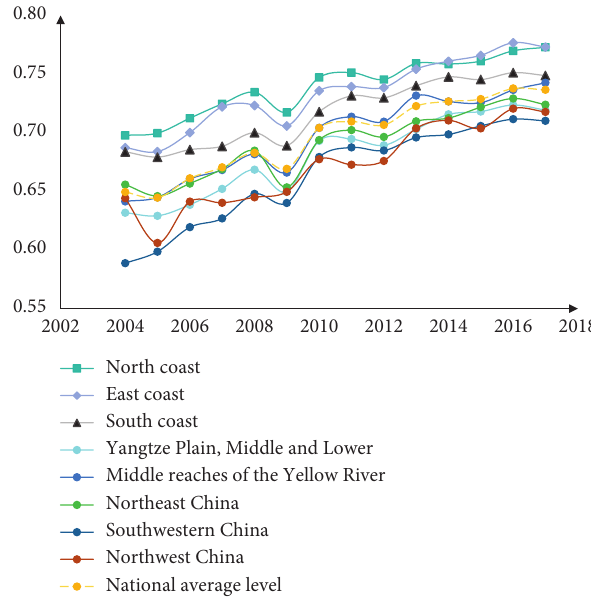
Figure 6: Trends of CCD in eight regions from 2004 to 2017. Table 8: The regression results of the SLM